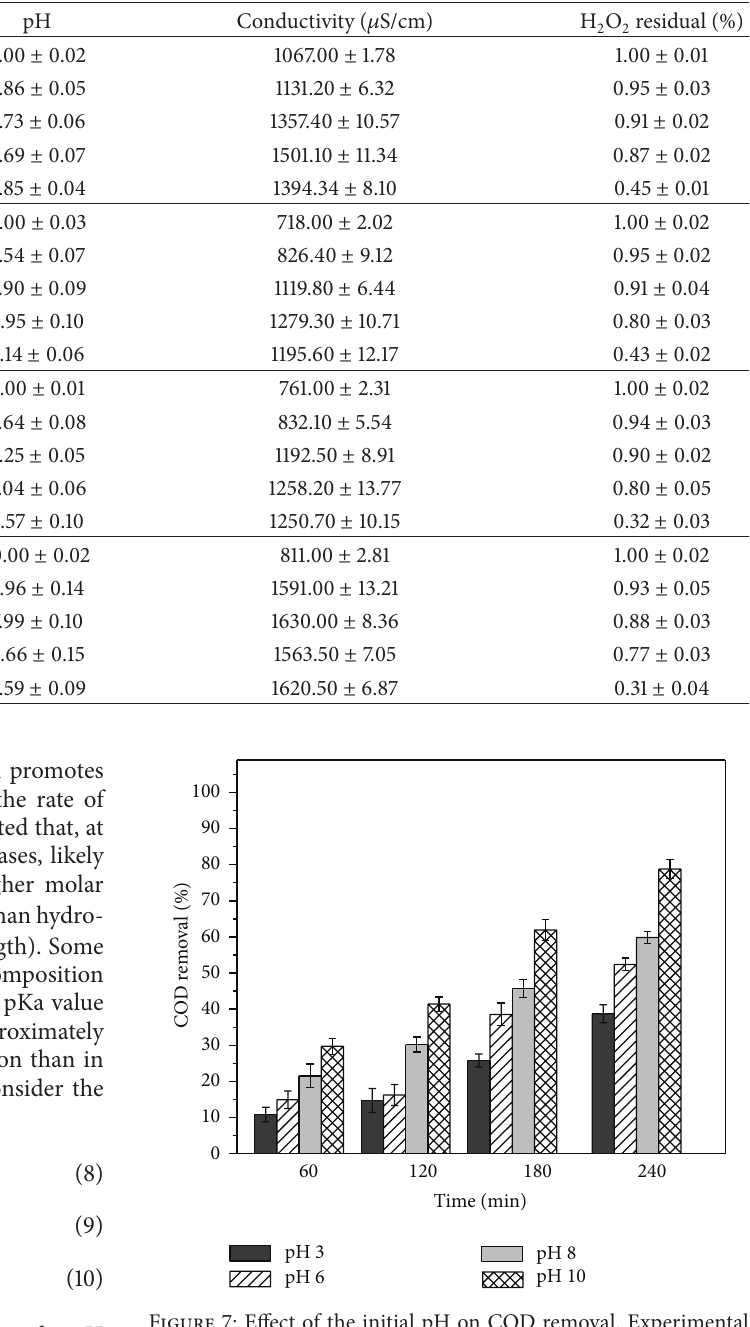
Figure 7: Effect of the initial pH on COD removal. Experimental conditions: UV/1% H 2 O 2 and 25 ∘